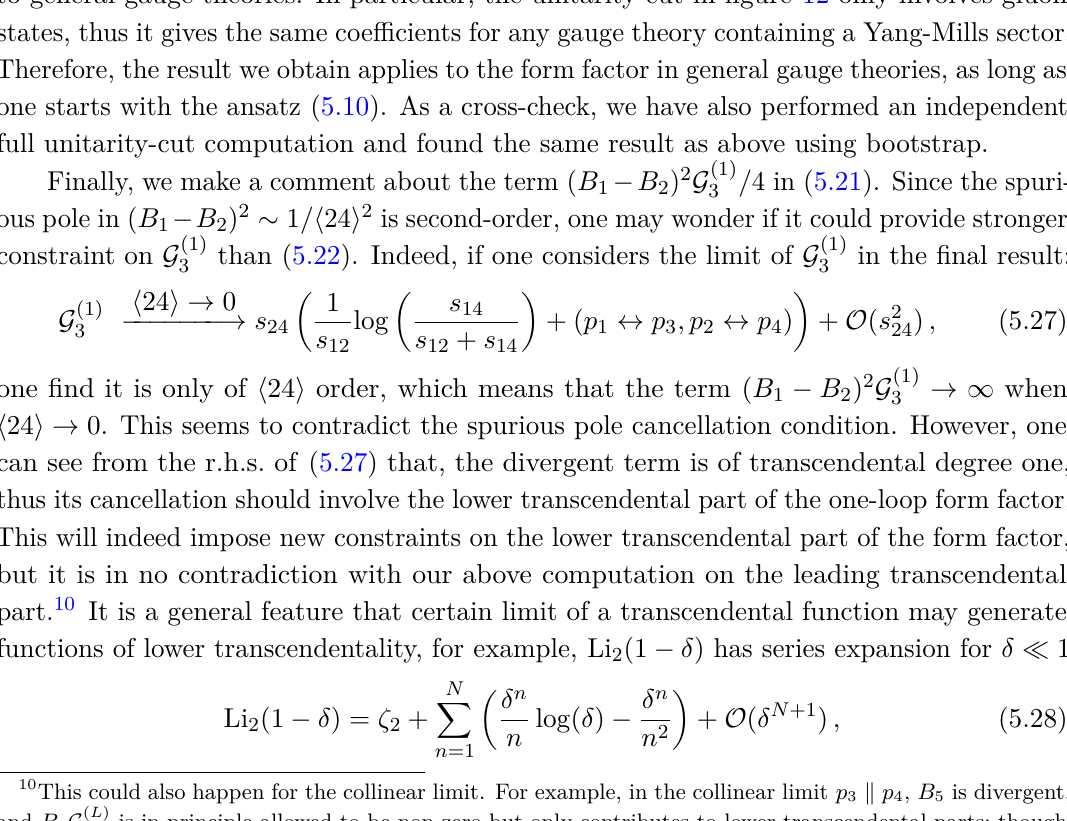
Table 4. Solving ansatz via constraints for the one-loop four-point form factor of tr( F 3 )